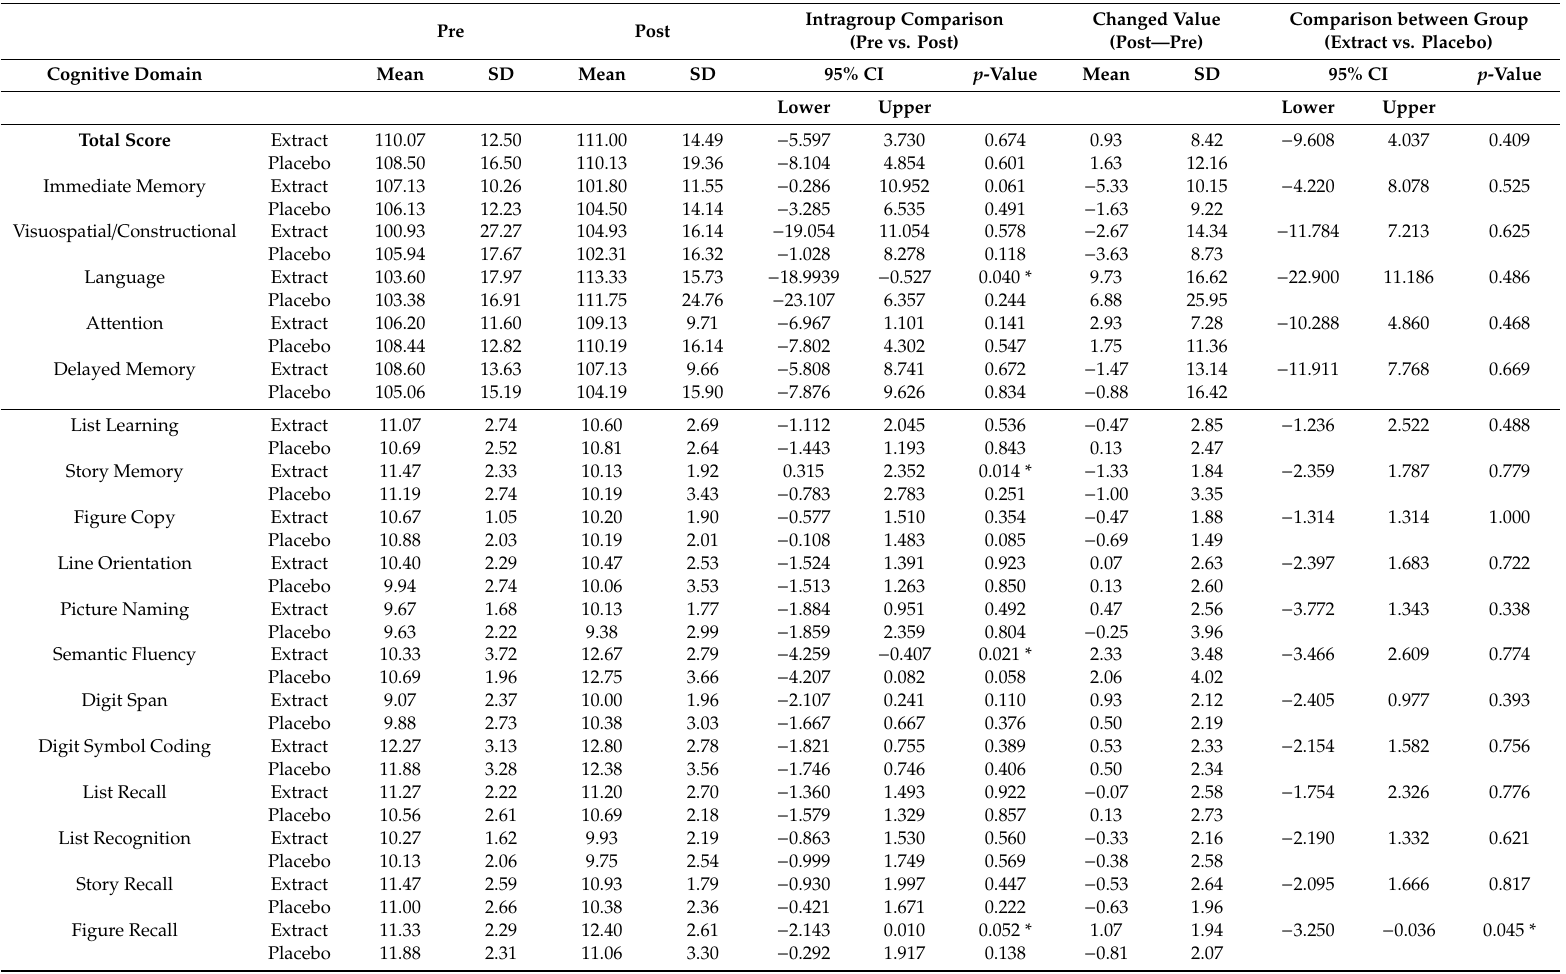
Table 2. Changes in Repeatable Battery for the Assessment of Neuropsychological Status (RBANS) scores between ES extract plus DR extract intake and placebo